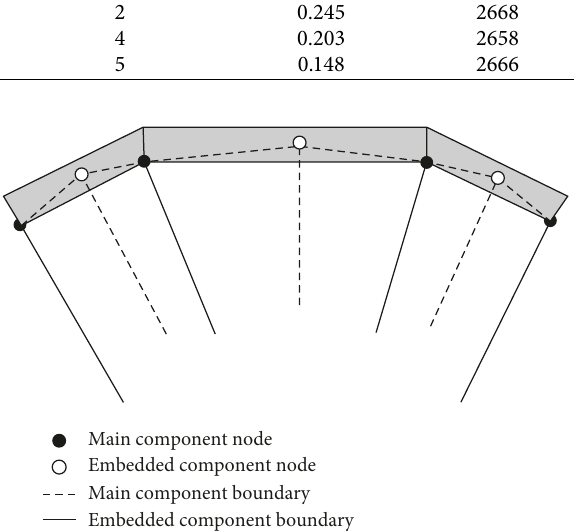
Figure 4: Distribution diagram of embedded